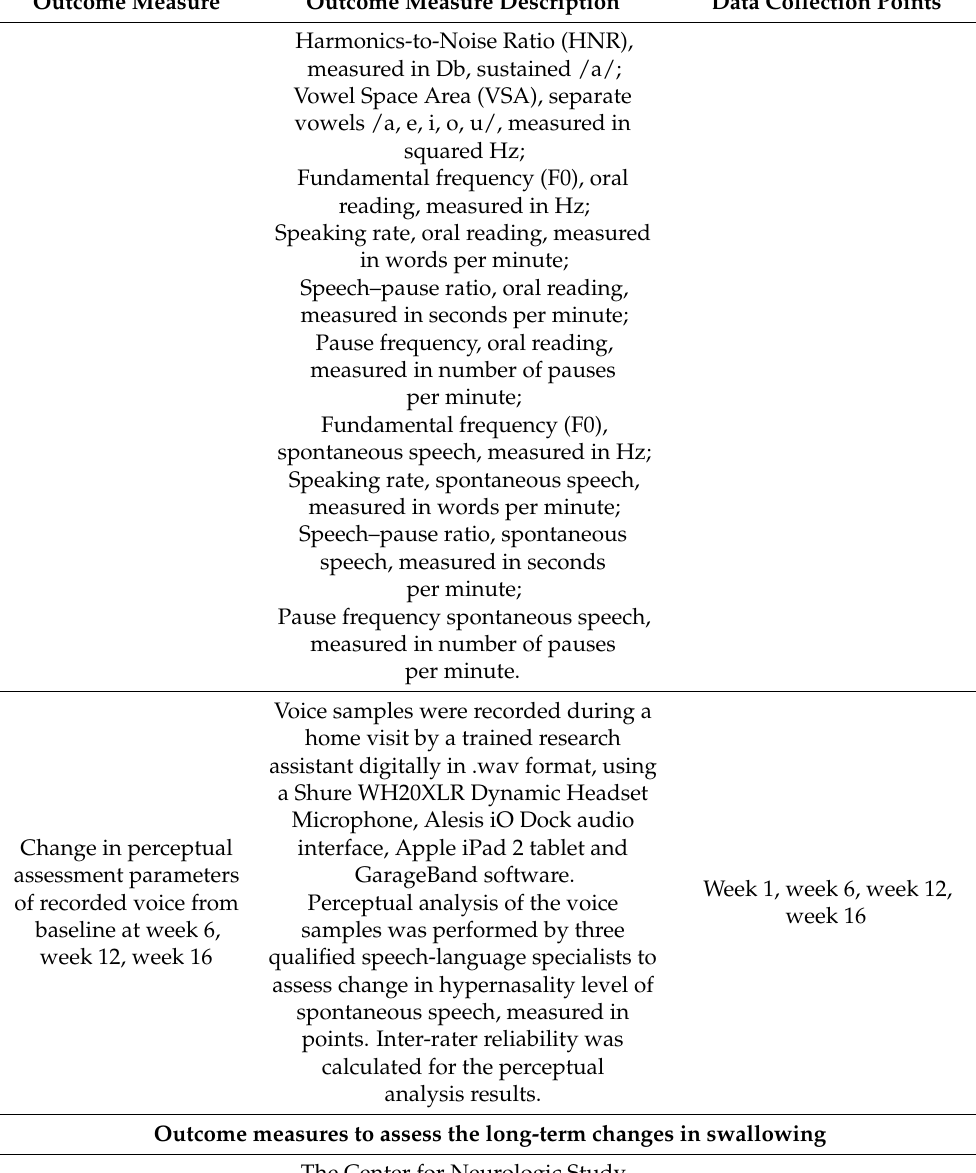
Table 2. Cont. Outcome